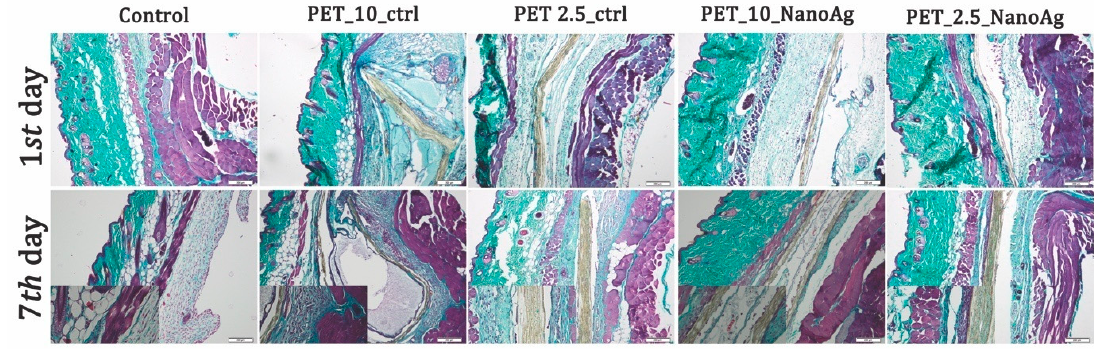
Figure 14. Gomori’s trichrome stain of PET control and PET_X_NanoAg-implanted